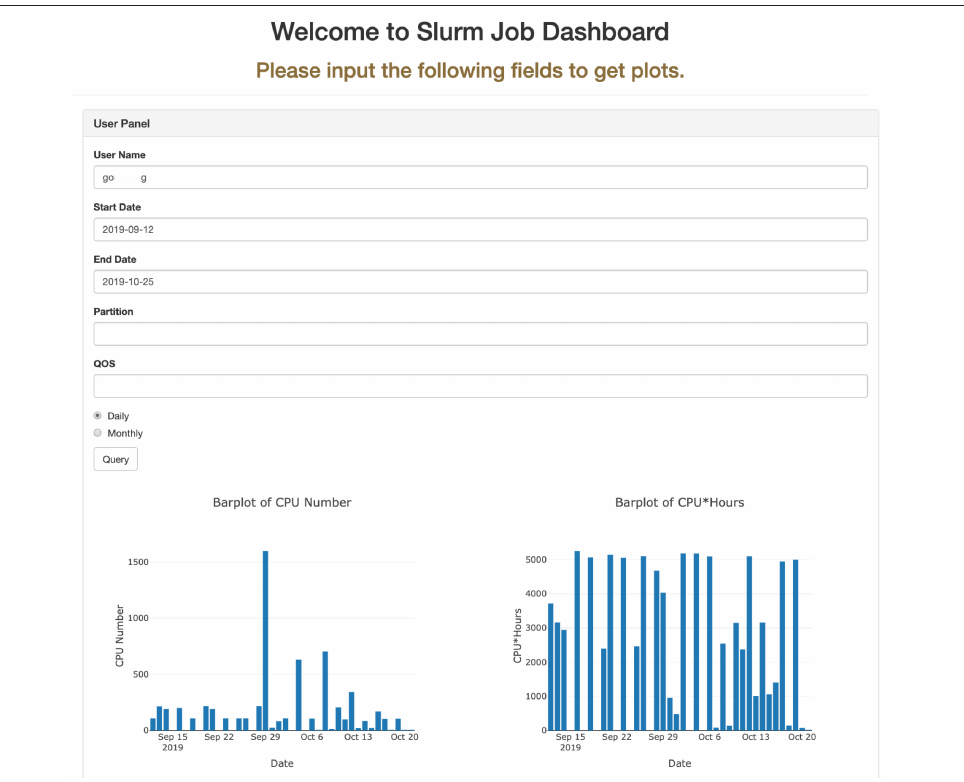
Figure 5: The job dashboard plots of